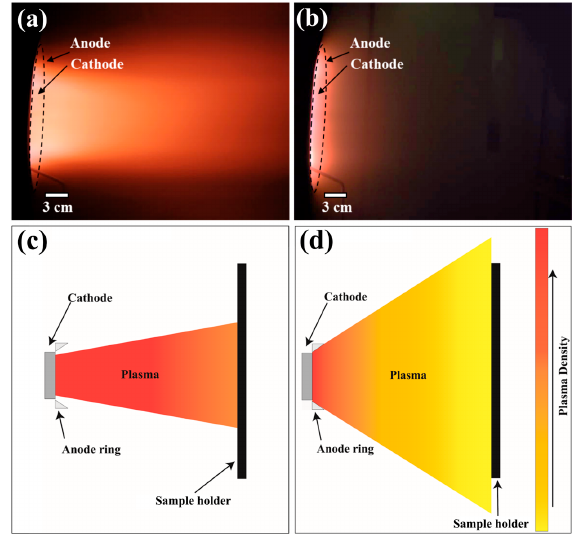
Figure 3. Side-view images (camera placed at 87 ° with respect to the surface normal) of the plasma plume emanating from the cathode are depicted for the cases of the 0 ( a ) and 2 A ( b ) coil currents. The pictures were acquired with an exposure of 4 ms. The cross-sections of the plasma plume are schematically drawn (not to scale) for the 0 ( c ) and 2 A ( d ) coil